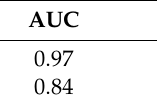
Table 5. Comparison between classifiers.